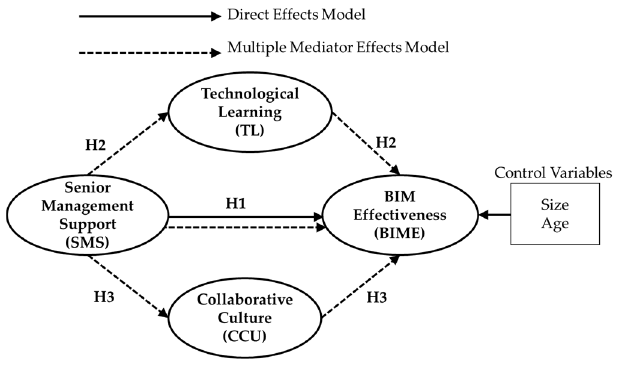
Figure 1. The research model and hypotheses.